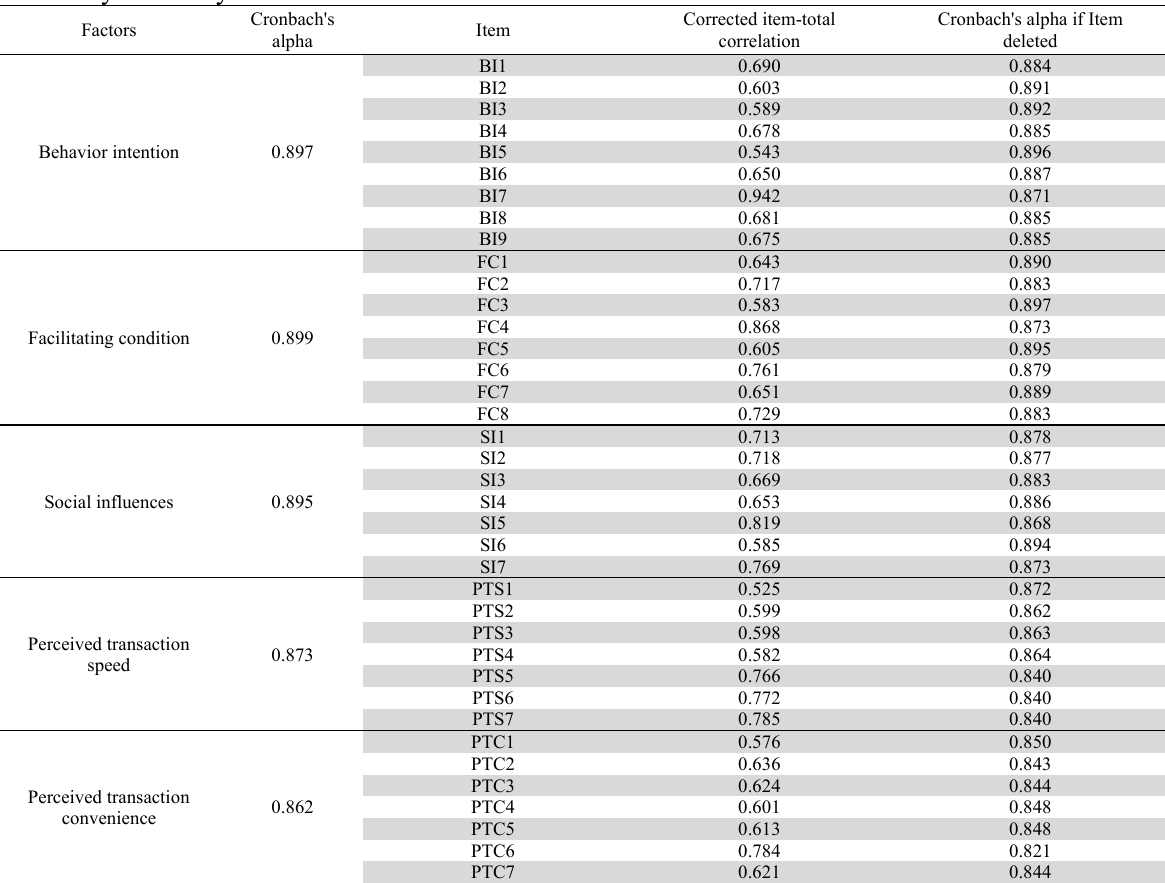
Reliability test